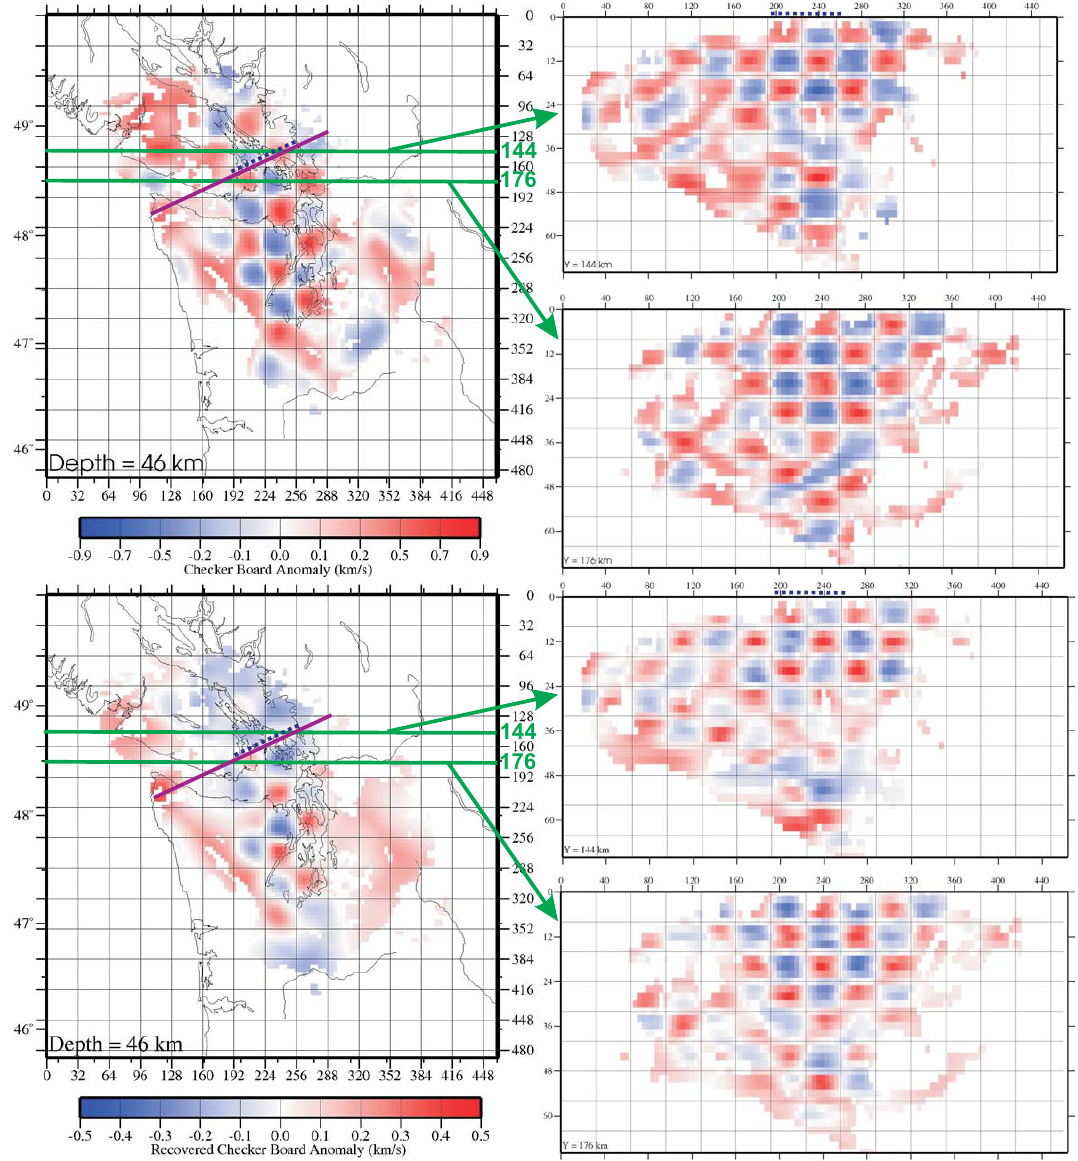
Fig. 3. Recovered P-wave (top) and S-wave (bottom) checkerboard anomaly pattern (32km × 32km × 8km) for estimating horizontal and vertical resolution is shown in the figure by one horizontal slice at 46km depth (shown on the left) and two E–W vertical slices (close to the main profile) at distances of 144km and 176km positions in the N–S direction (shown on the right). Purple line marks the position of the main cross-section discussed in the main article. Blue dotted line shows the inferred position of the forearc mantle